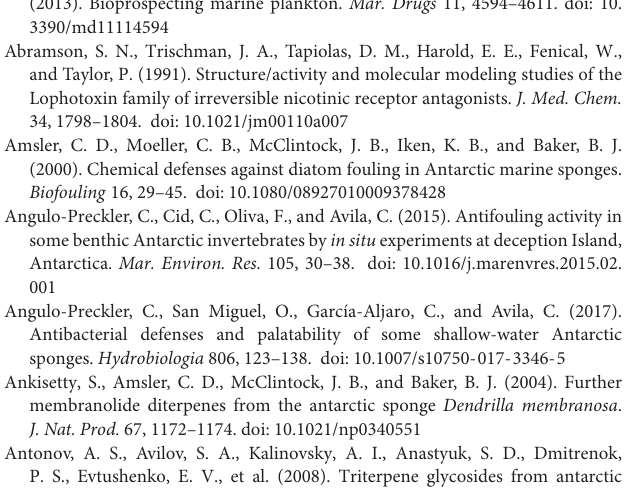
Taboada, S., et al. (2011). Triterpene glycosides from Antarctic sea cucumbers III. Structures of liouvillosides A4 and A5, two minor disulphated